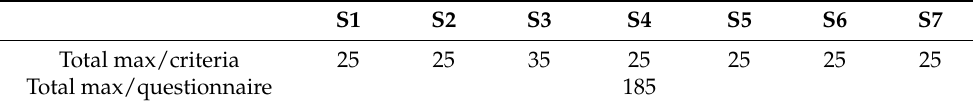
Table 3. Maximum score that can be